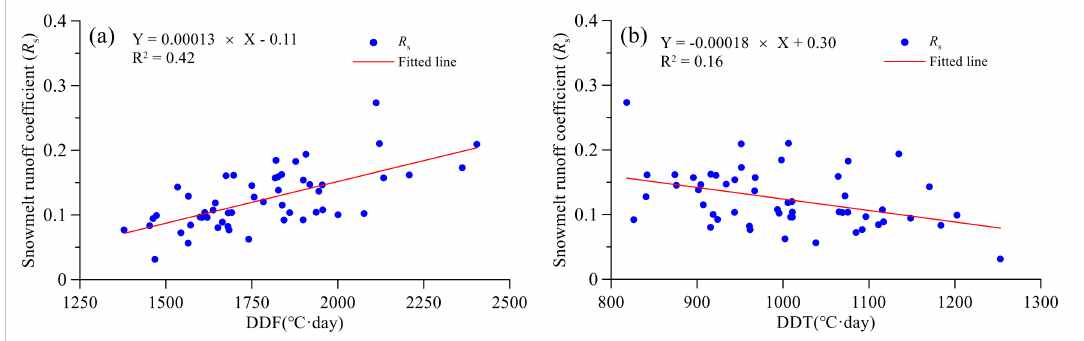
Figure 11. The correlation between direct snowmelt runo ff coe ffi cient and freezing–thawing indices (DDF ( a ), DDT ( b